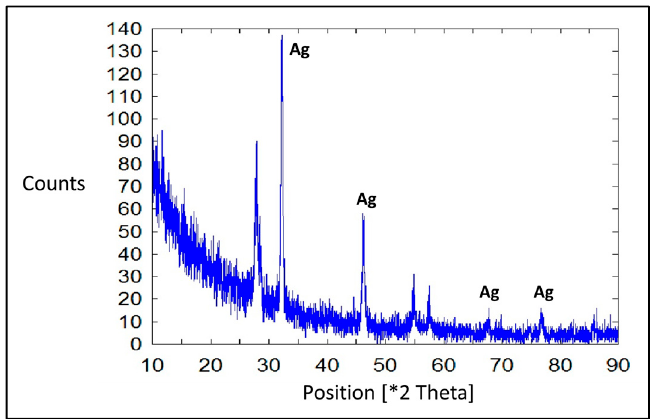
Figure 6. XRD spectrum of synthesized AgNPs.